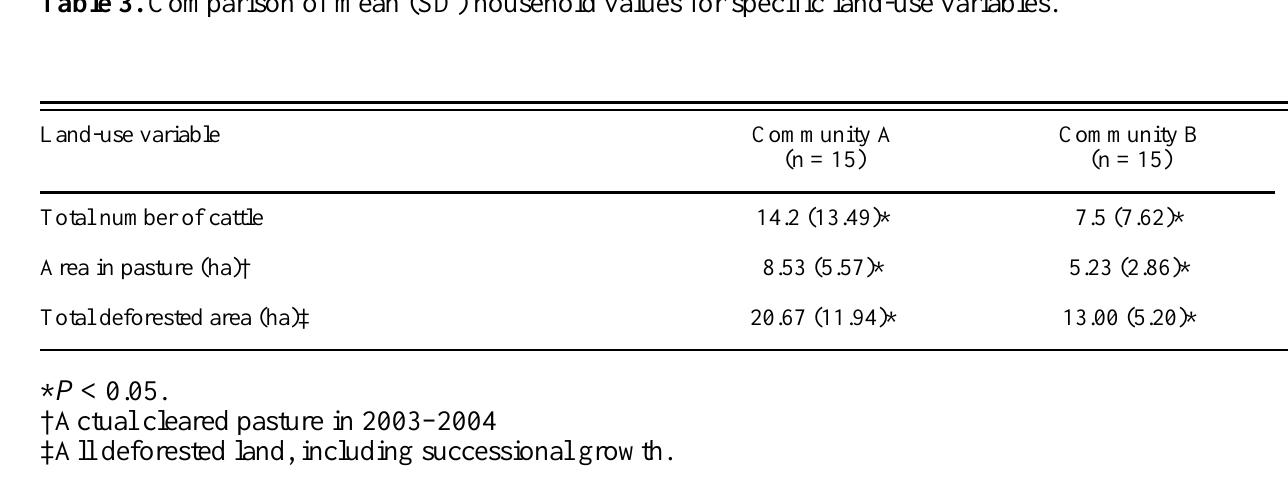
Table 3. Comparison of mean (SD) household values for specific land-use